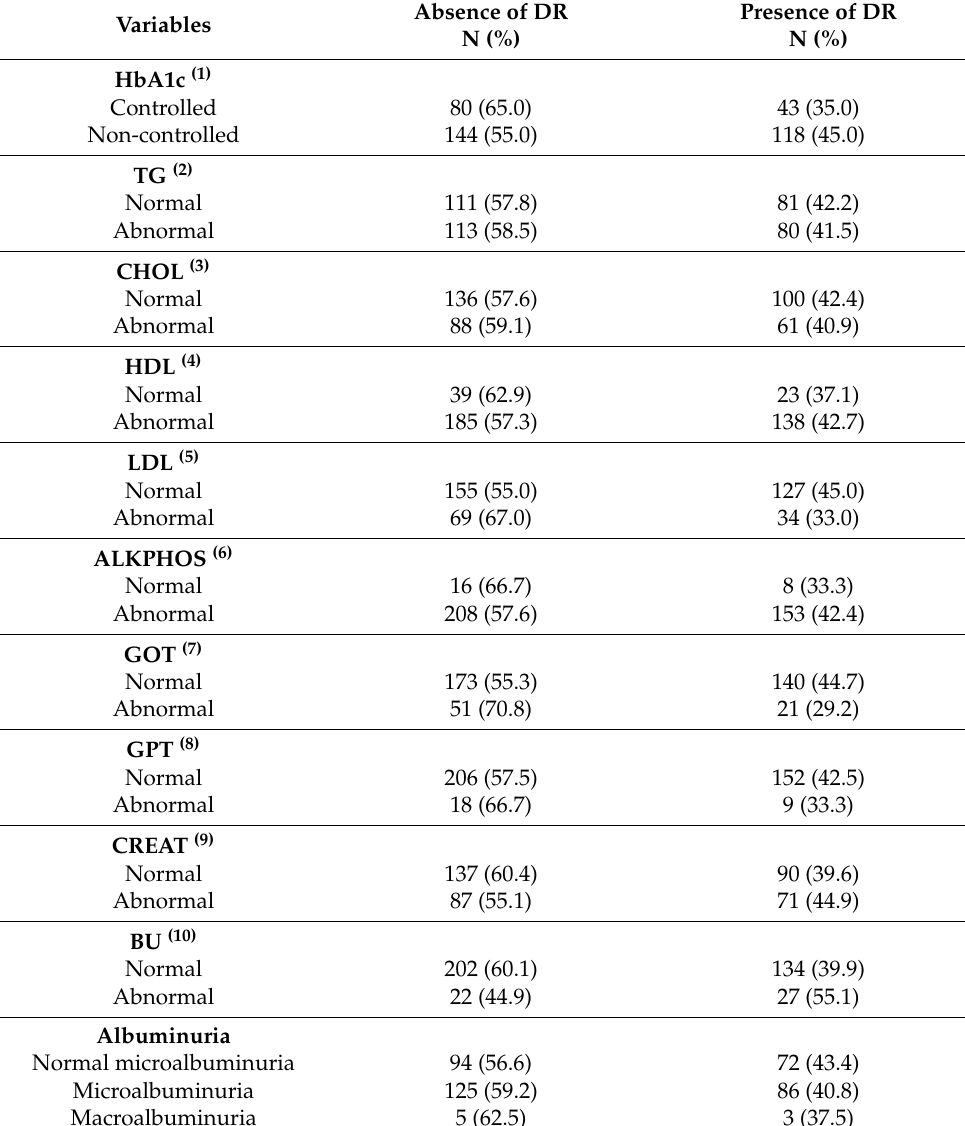
Table 2. Laboratory characteristics of diabetic